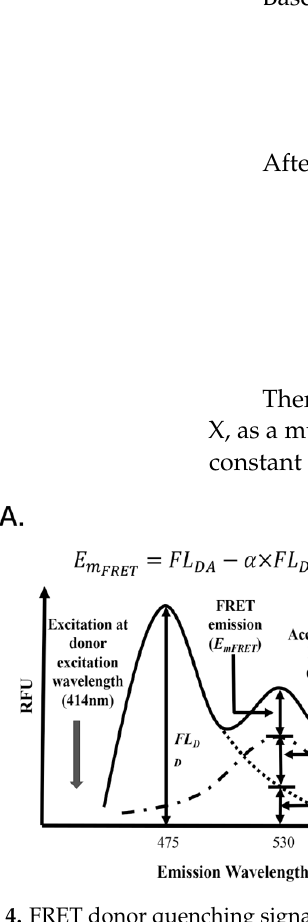
Figure 4. FRET donor quenching signal for protein equilibrium constant K D determination: A. The FRET donor quenching resulted from protein–protein interaction is used to determine protein–protein bound complexes; B. The FRET donor quenching signals at three concentrations of donor are determined with increasing concentrations of FRET acceptor, using the method in A.